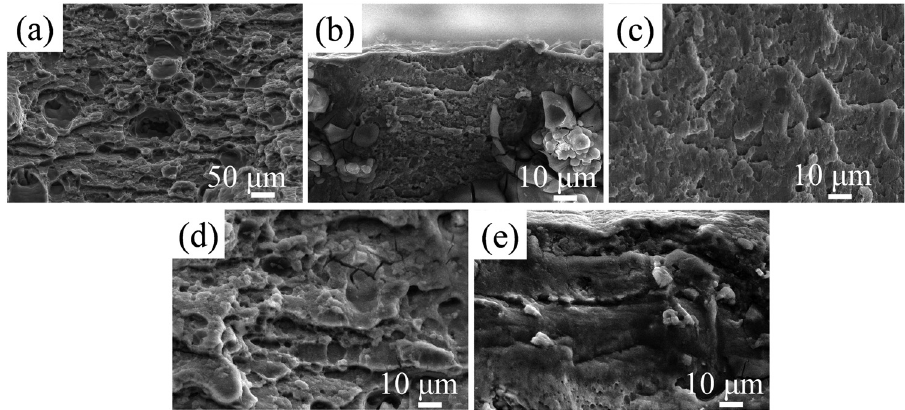
Figure 5: Microstructure of base metal fracture: ( a ) in air condition, ( b ) in the condition of cathode potential of – 0.8 V, ( c ) in the condition of cathode potential of – 1 V, ( d ) in the condition of cathode potential of – 1.2 V, and ( e ) in the condition of cathode potential of – 1.4 V.